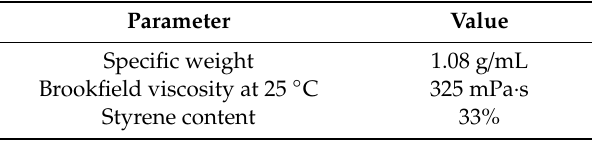
Table 1. Basic resin parameters.